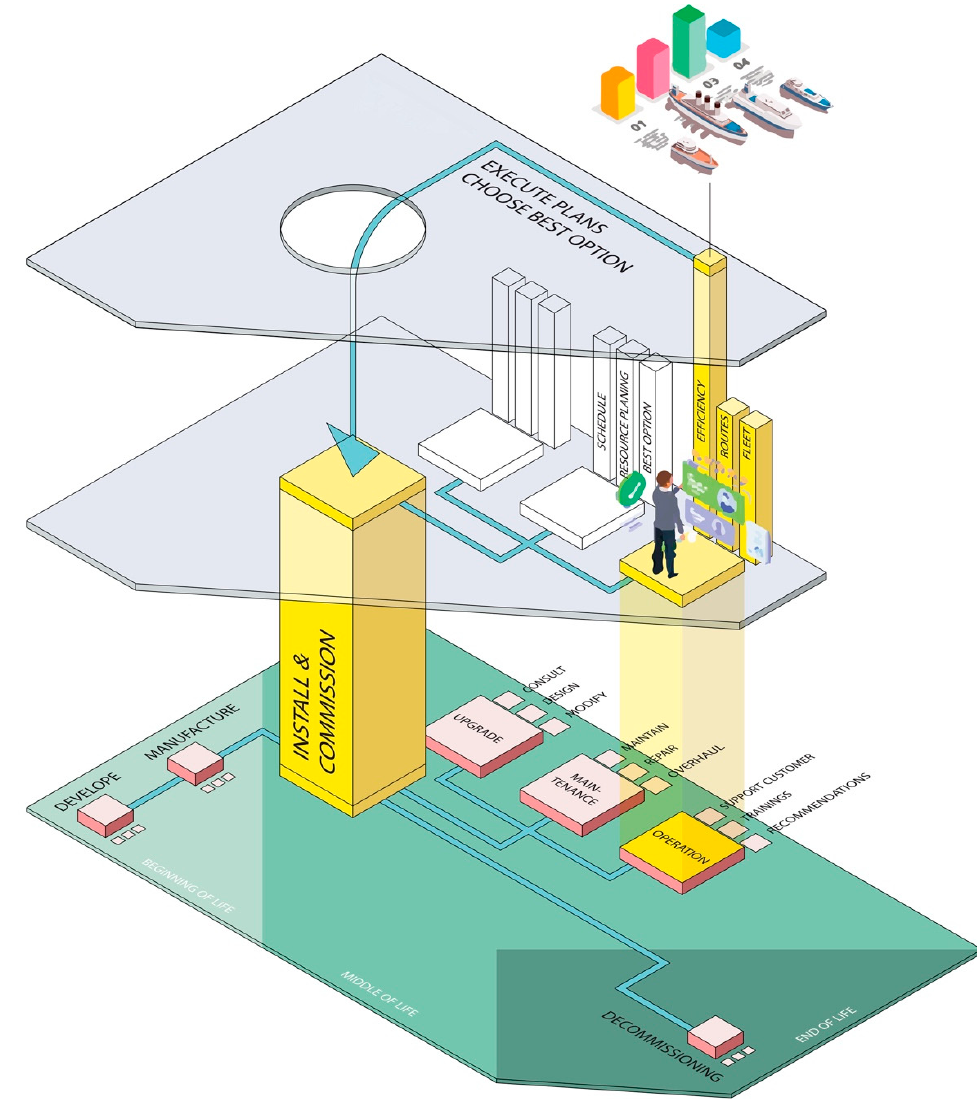
Figure 4. Example of a sketch from Case 3, showing the analysis simulation and application layers with the identification of the business challenges, business intelligence, and consequence. Visualization: Rohner, D., & Müller-Csernetzky, P.